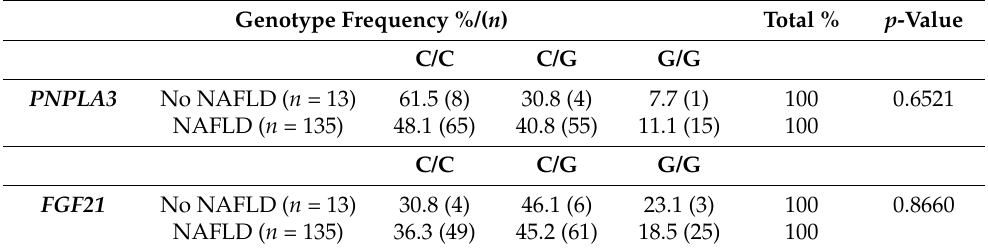
Table 5. Frequency of the single nucleotide polymorphisms in PNPLA3 and in FGF21 .